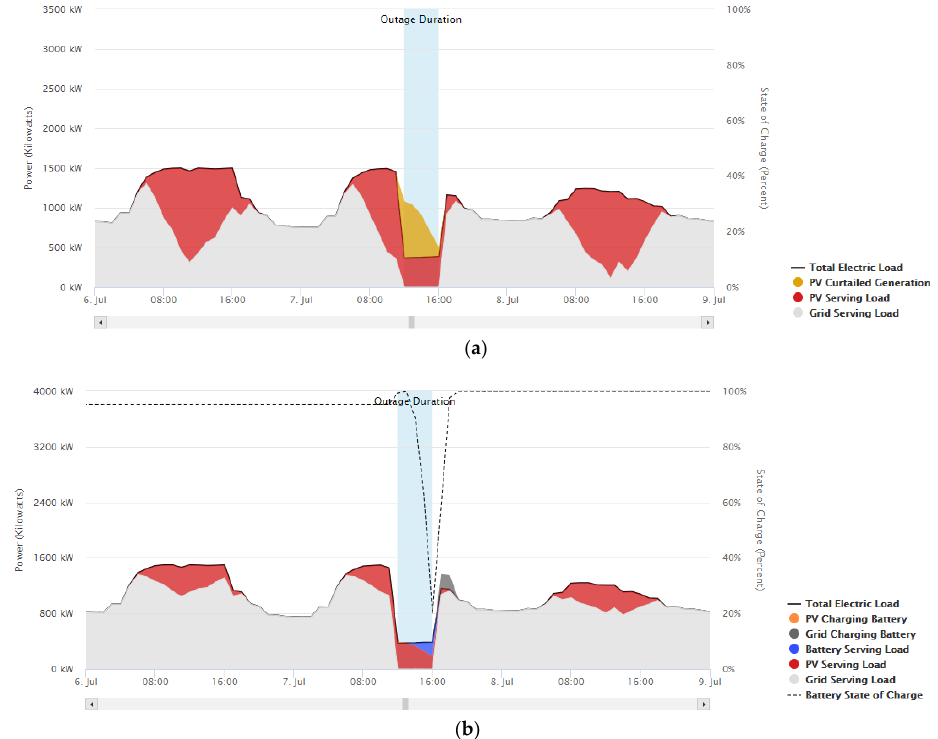
Figure 6. System operation under ( a ) ToU rate and ( b ) flat rate with 4-h outage at 12 p.m.